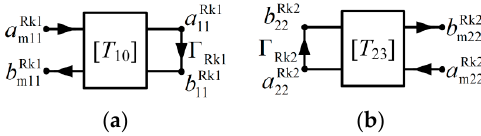
Figure 2. Single-port calibration. ( a ) Error model for standard R k1 measurement; ( b ) Error model for standard R k2 measurement.